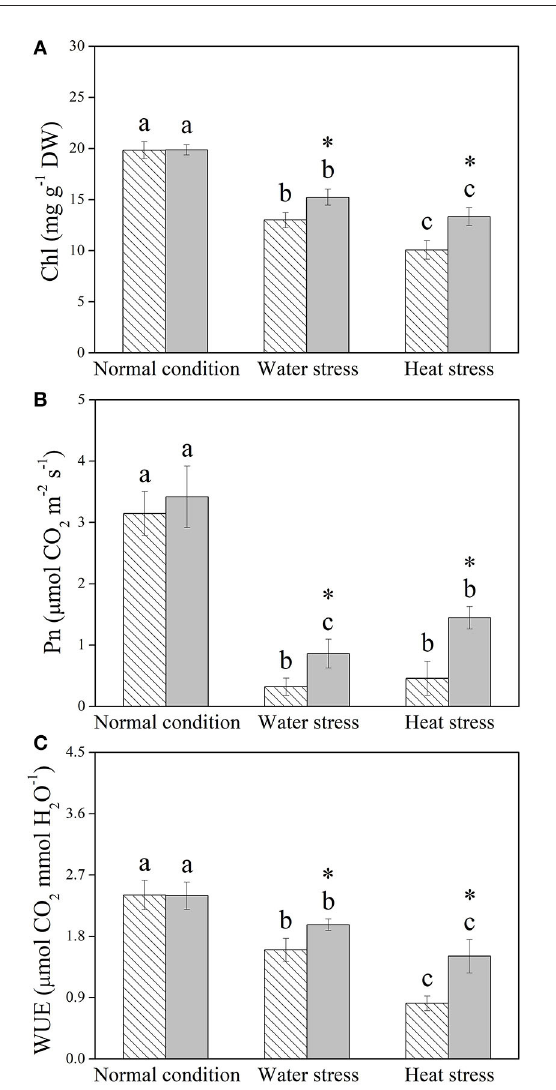
FIGURE3 Changes in (A) chlorophyll (Chl) content, (B) net photosynthetic rate (Pn), and (C) water use efficiency (WUE) in response to Spm application under different conditions. Vertical bars indicate ± SE of mean ( n = 4). Different letters above striated or gray columns indicate significant differences for a particular treatment (Control or + Spm) for comparison across the normal condition, water stress, and heat stress; the asterisk “*” indicates significant differences between the control and the + Spm treatments under one particular condition (normal condition, water stress, or heat stress) based on LSD ( P < 0.05).